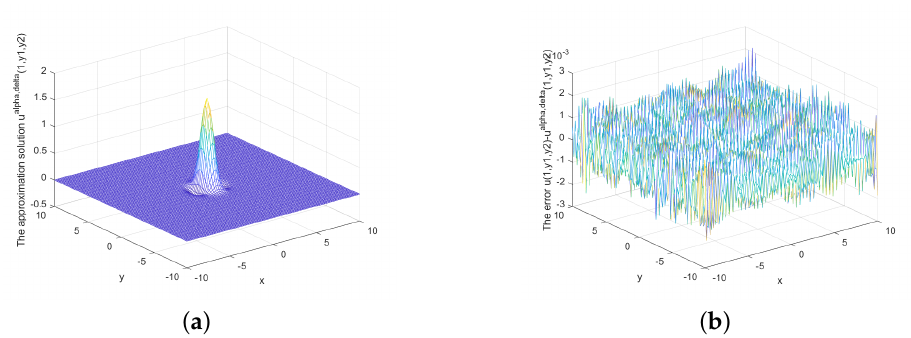
Figure 10. ( a ) The regularized solution and ( b ) error between regularized and exact solution when x = 0.5, δ = 1 × 10 − 7 under the posterior rule.